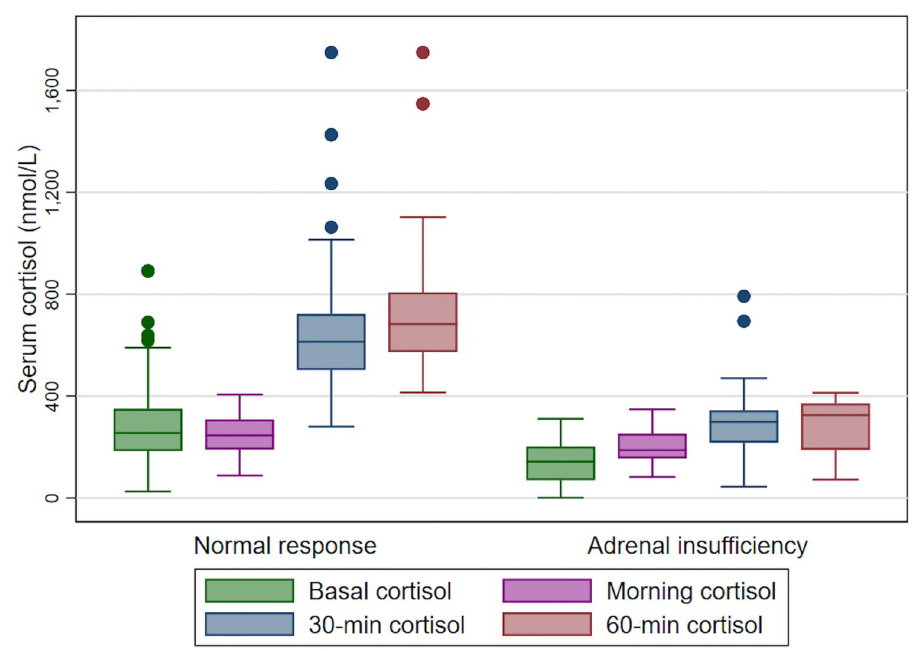
Fig 1. Box plot graph of serum basal cortisol, serum morning cortisol, 30 and 60-minutes cortisol after ACTH stimulation test categorized by adrenal insufficiency